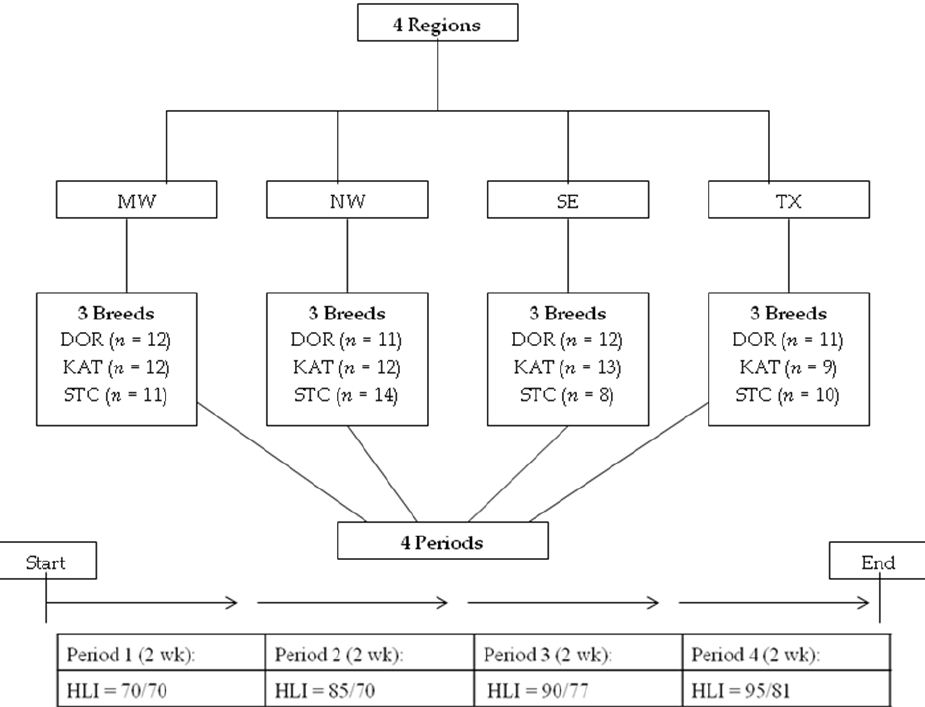
Figure 1. Schematic presentation of the experimental design to evaluate effects of different heat load index (HLI) conditions on three breeds, namely, Dorper (DOR), Katahdin (KAT), and St. Croix (STC) from four different climatic regions, i.e., Midwest (MW), Northwest (NE), Southeast (SE), and central Texas (TX), of USA. The entire study period was 10 wk, with the first week for adaptation to the facility and thermoneutral conditions and the last week for readjustment to thermoneutral con- ditions. Animal measurements occurred in the 8 wk experiment, with four 2 wk periods.